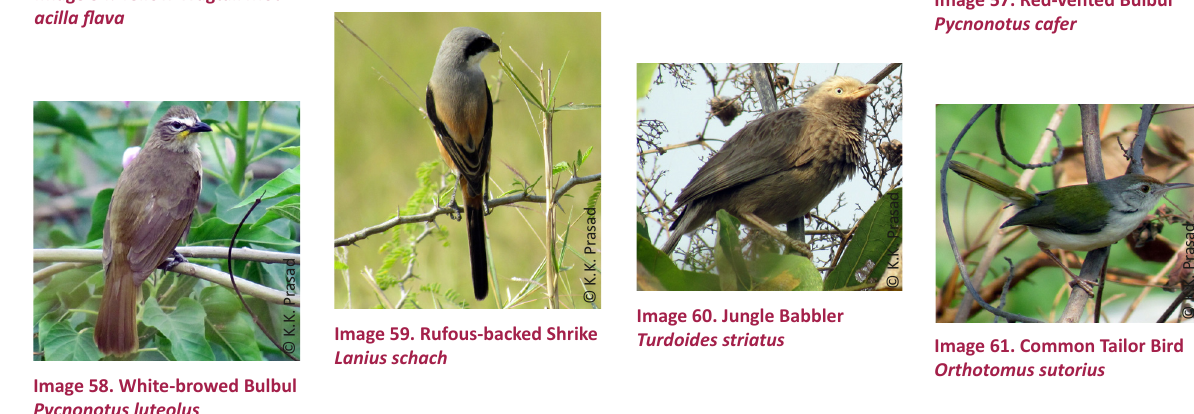
Image 58. White-browed Bulbul Pycnonotus luteolus